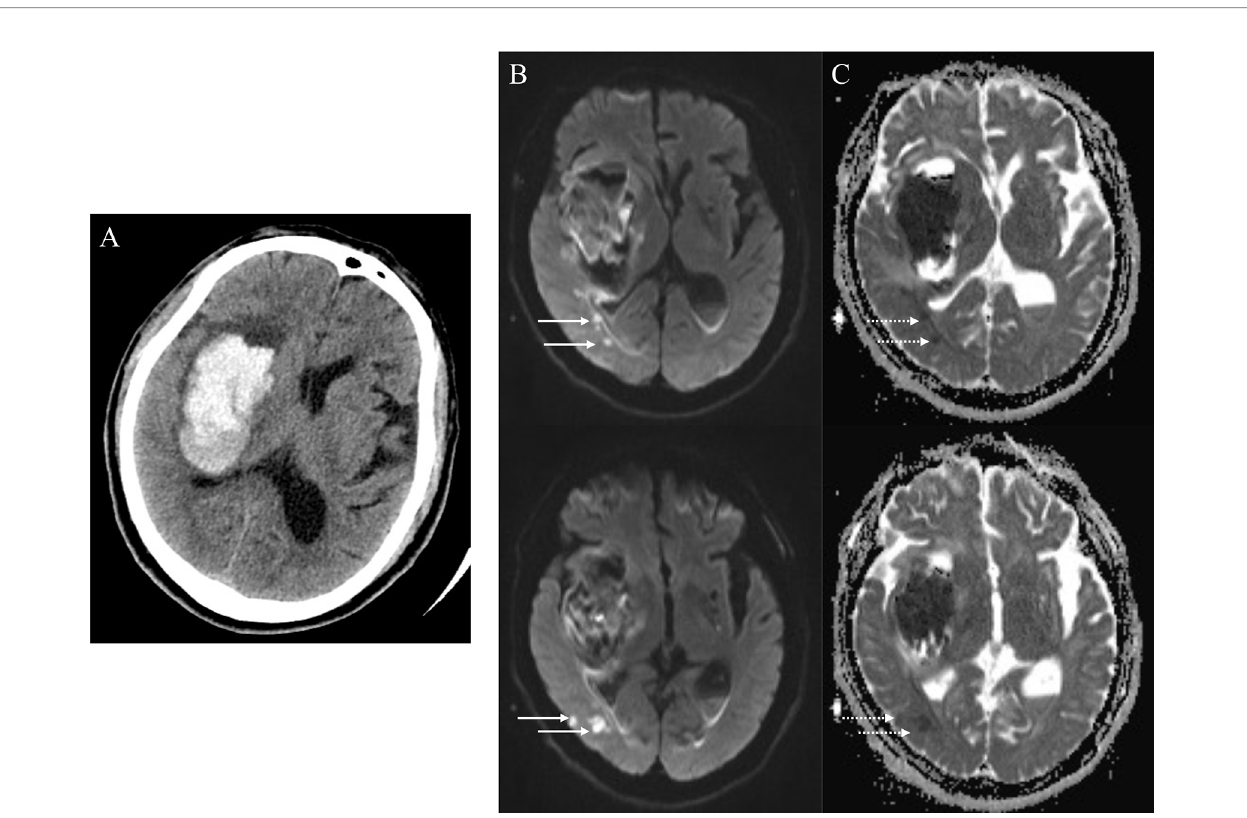
FIGURE 2 | Positive remote diffusion-weighted imaging lesions in a 65-year old man with right basal ganglia hemorrhage (A) . Diffusion-weighted imaging shows hyperintensity lesions ( B , solid arrowheads) in ipsilateral occipito-temporal lobe, with corresponding hypointensity in apparent diffusion coef fi cient map ( C , dotted arrowheads) at the 8th day after ICH